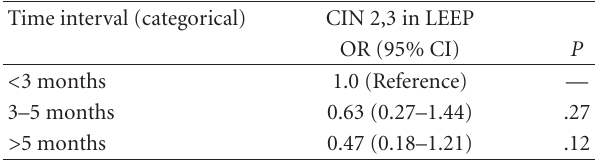
Table 2: Univariate logistic regression of time interval and CIN 2,3 in